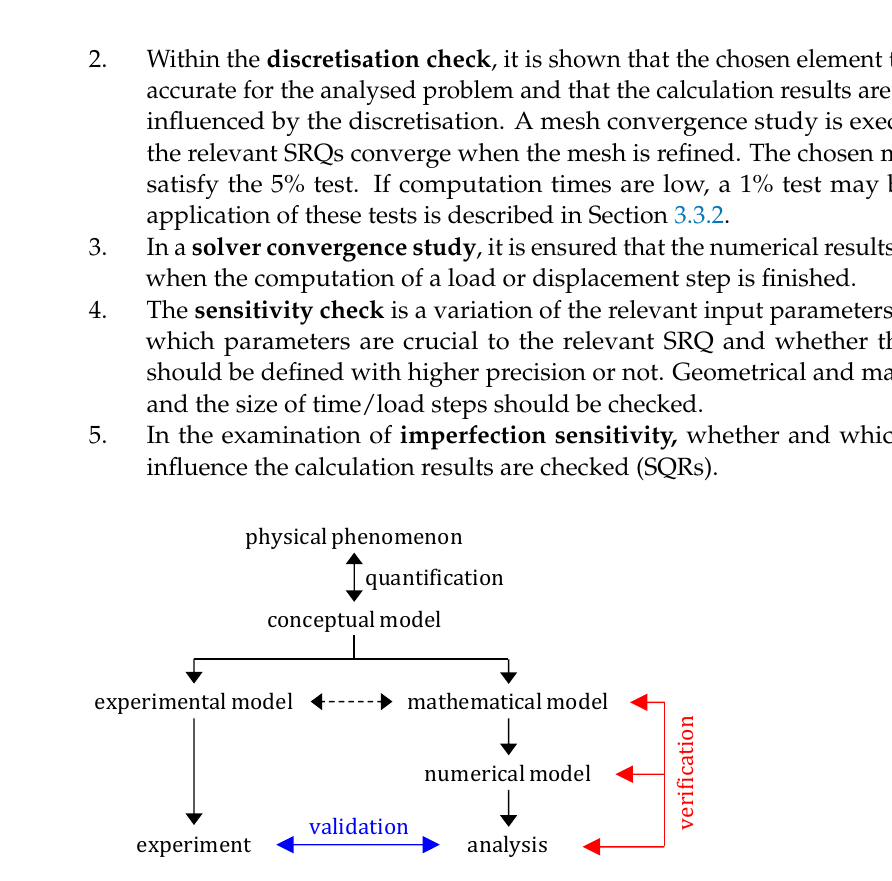
Figure 2. Interpretation of a validation and verification process [4].